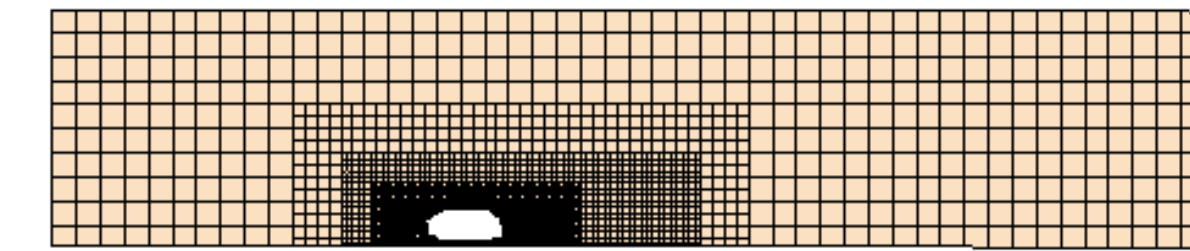
Figure 1. Volume mesh division of the overall computing domain at the y = 0 m section.